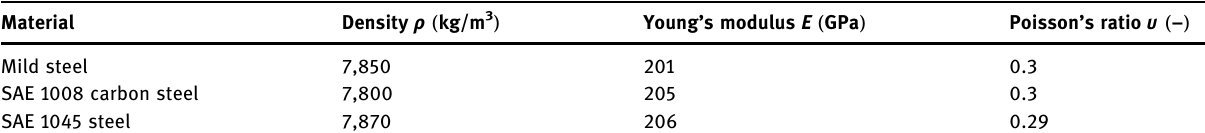
Table 2: Material properties of steel